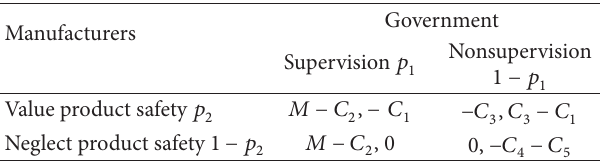
Table 2: Game matrix of the government and